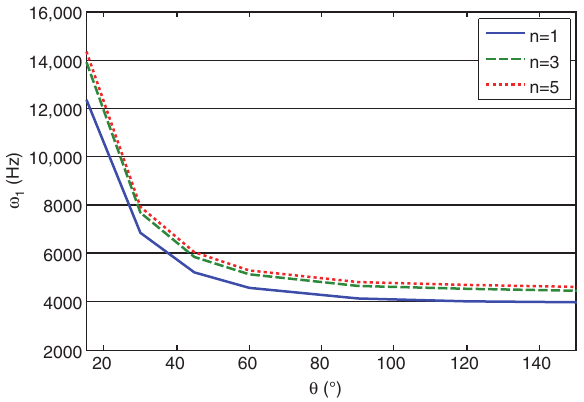
Figure 10 Variation in the first natural frequency of a fully clamped isotropic FG annular sector plate for different power-law exponents and different sector angles.